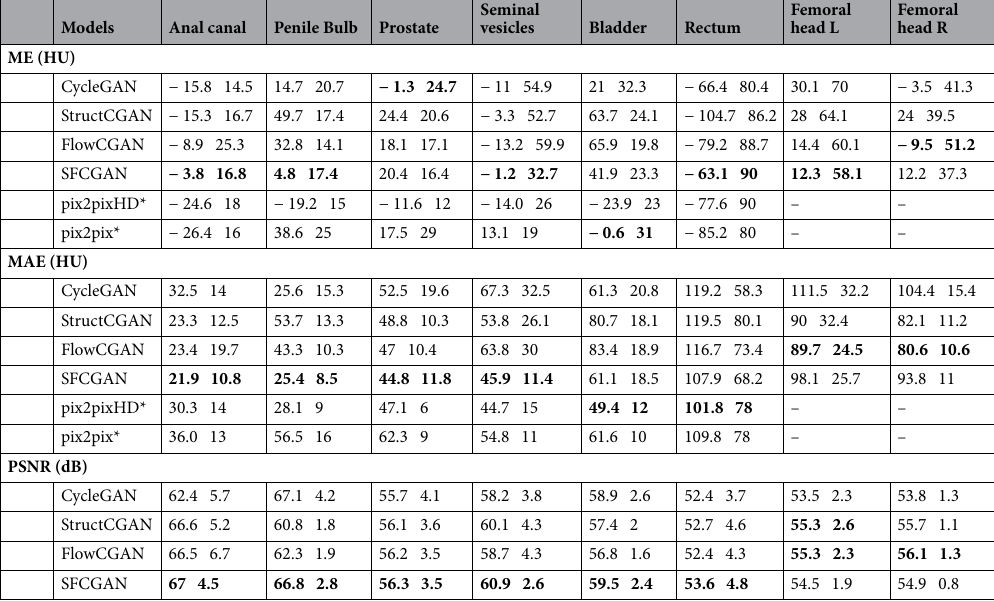
Table 3. ME, MAE and PSNR values of consensus delineations of organs. Best results are in bold font.